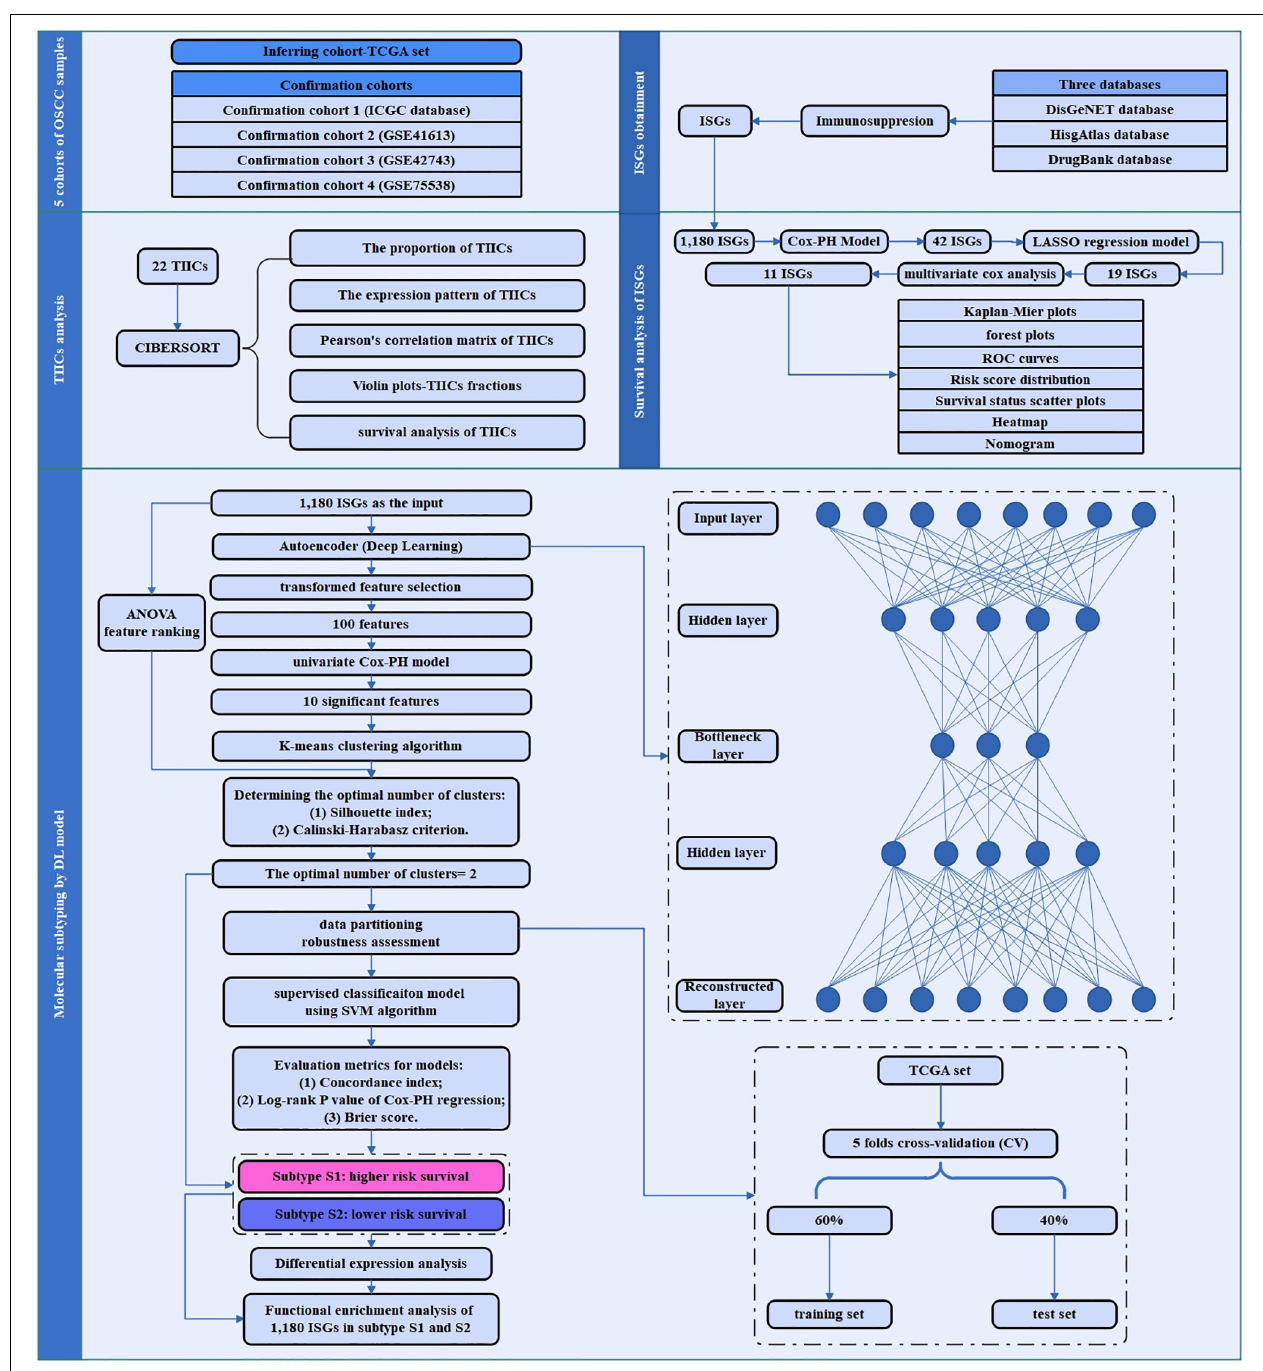
FIGURE 1 | The study flowchart of the current research. This flowchart consisted of five sections: sample data collection of five cohorts of OSCC sample; ISGs obtainment, TIICs analysis, survival analysis of ISGs, and molecular subtyping by DL-based model.